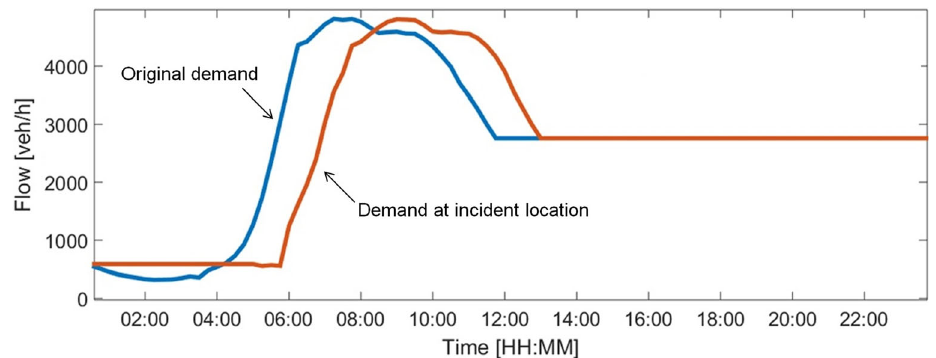
Fig. 7 Traffic flow measured at incident location compared with demand entering the